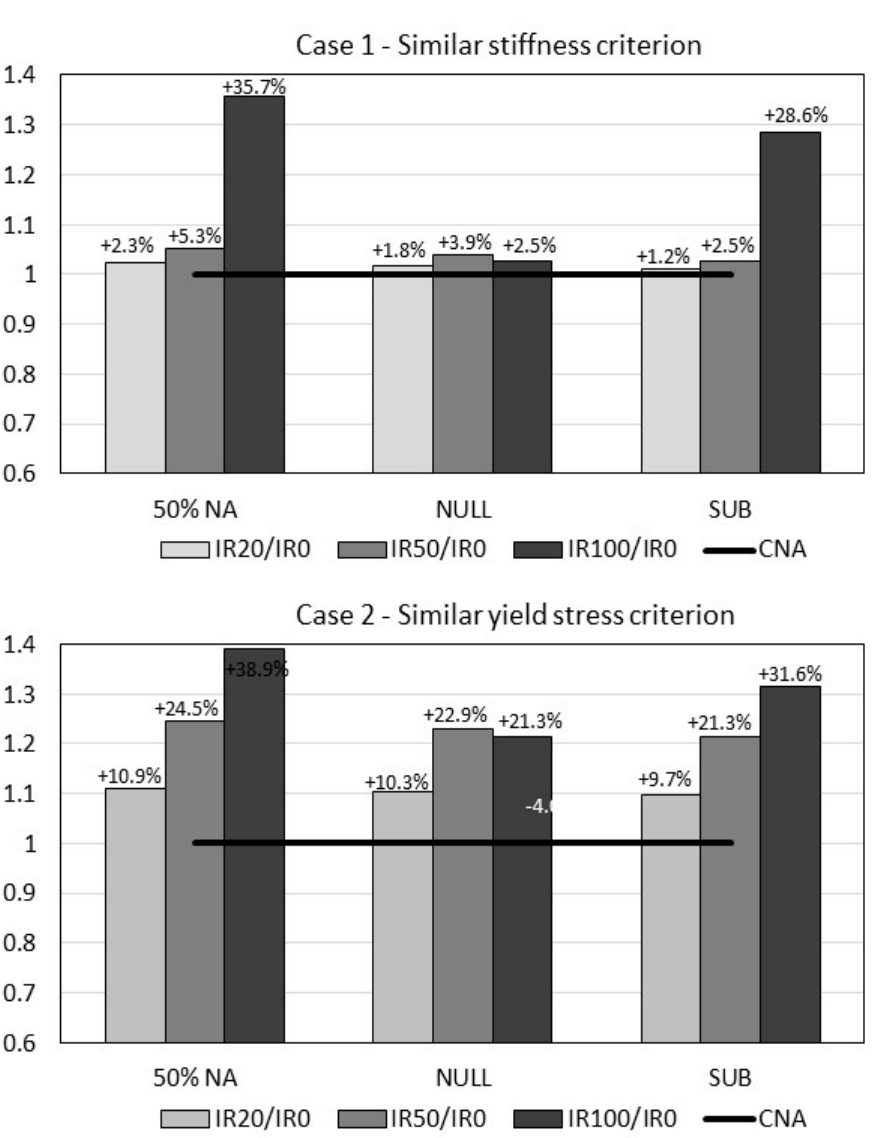
Figure 3. Variation of lining’s cost per unit length of tunnel for three different costs of Coarse Recycled Concrete Aggregates.